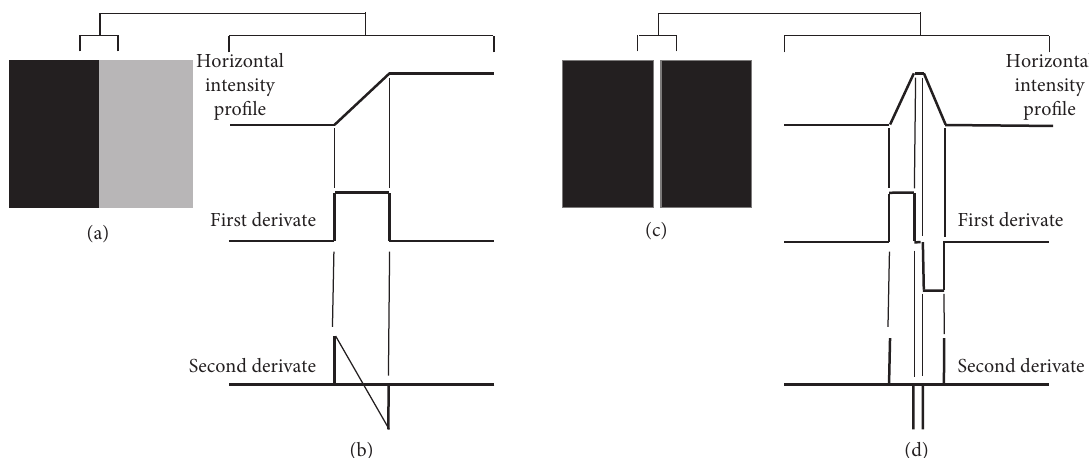
Figure 2: Schematic of the gray model and its first and second derivatives. (a) Ramp edge model. (b) Gray profile of the ramp edge model and its corresponding first and second derivatives. (c) Roof edge model. (d) Gray profile of the roof edge model and its corresponding first- and second-order